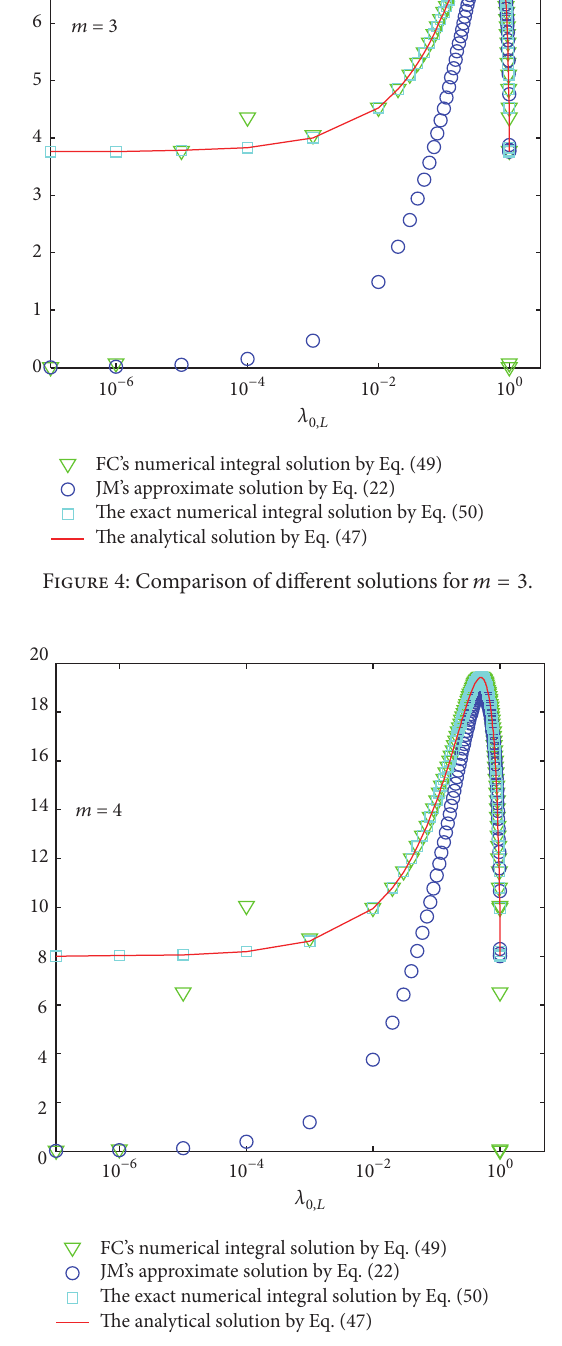
Figure 5: Comparison of different solutions for 𝑚 = 4